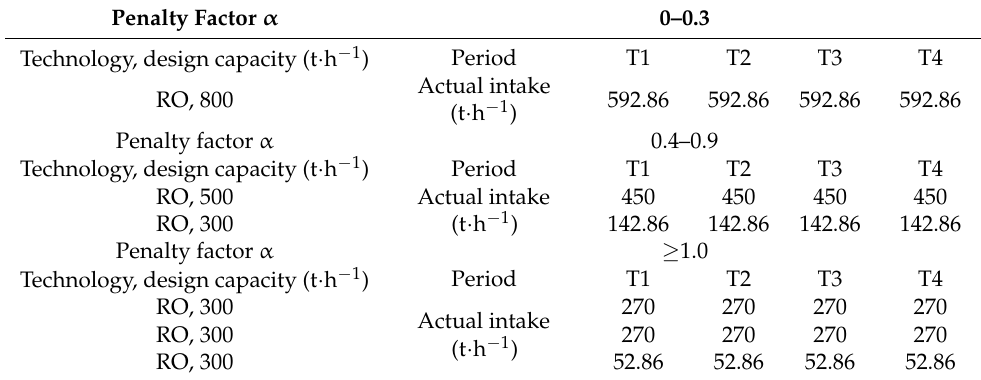
Figure 3. Annualized total cost distribution of the water supply network (Scenario 1). Table 4. Optimal operation scheme under different penalty factors (Scenario 1). Penalty Factor α